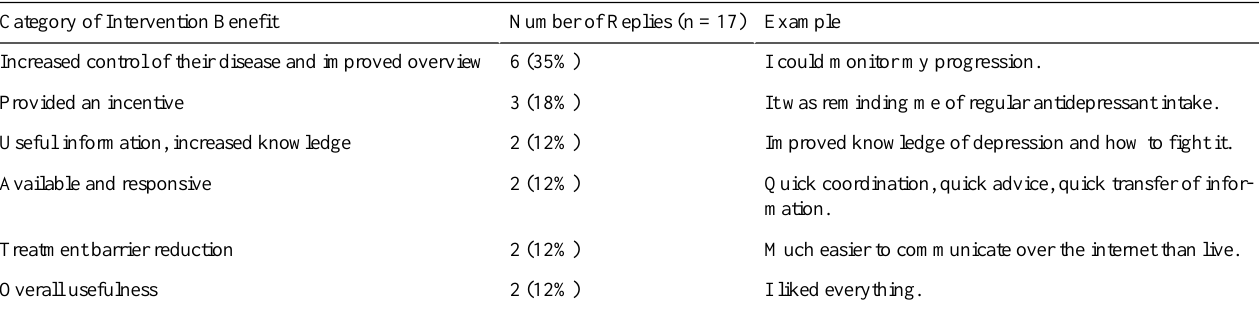
Table 6. Positive feedback provided by patients in the intervention group: categories and examples